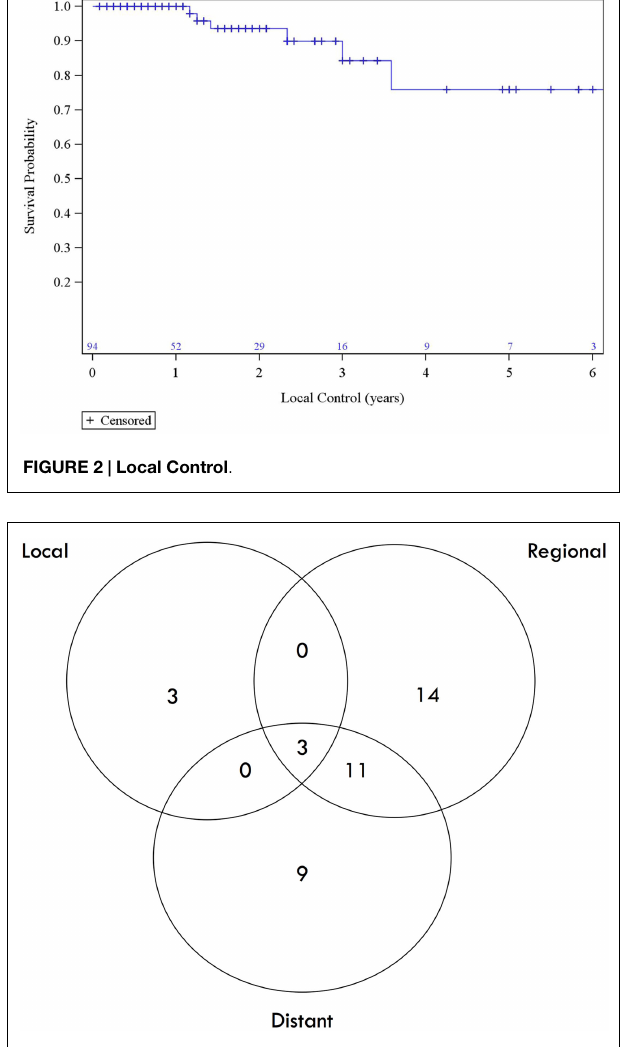
FIGURE 3 | Pattern of Failure .